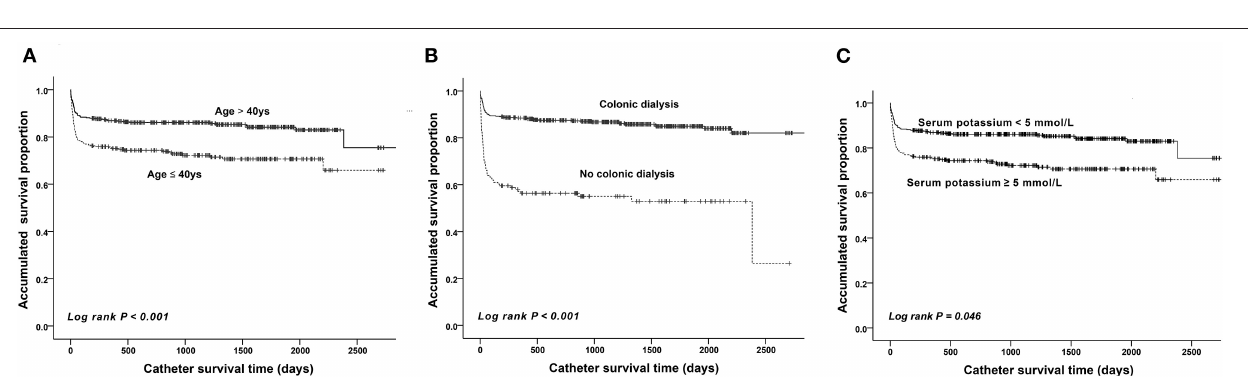
FIGURE 5 | Kaplan–Meier survival curves showing the accumulated age-adjusted catheter survival time (A) , colonic dialysis (B) , and serum potassium level (C) .